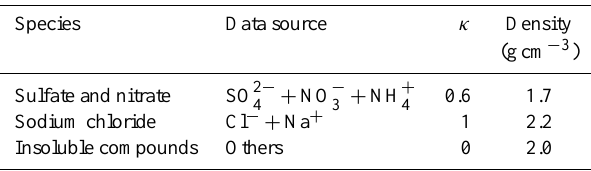
Table 2. Effective hygroscopicity parameters ( κ ) and densities of the four category